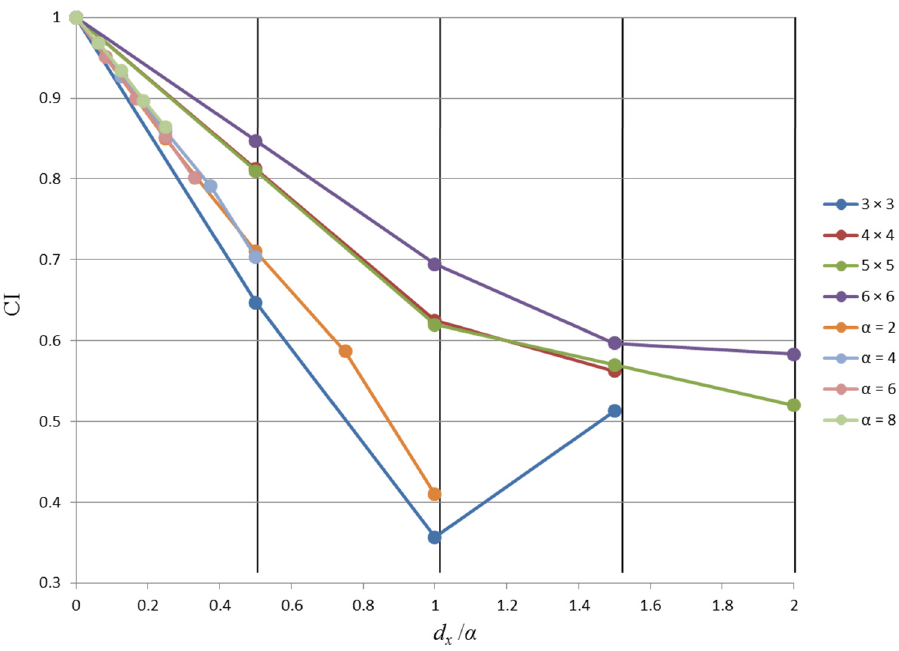
Figure 9. Comparison of our schemes with MTVSS scheme for shifting the same percentage of the shares.